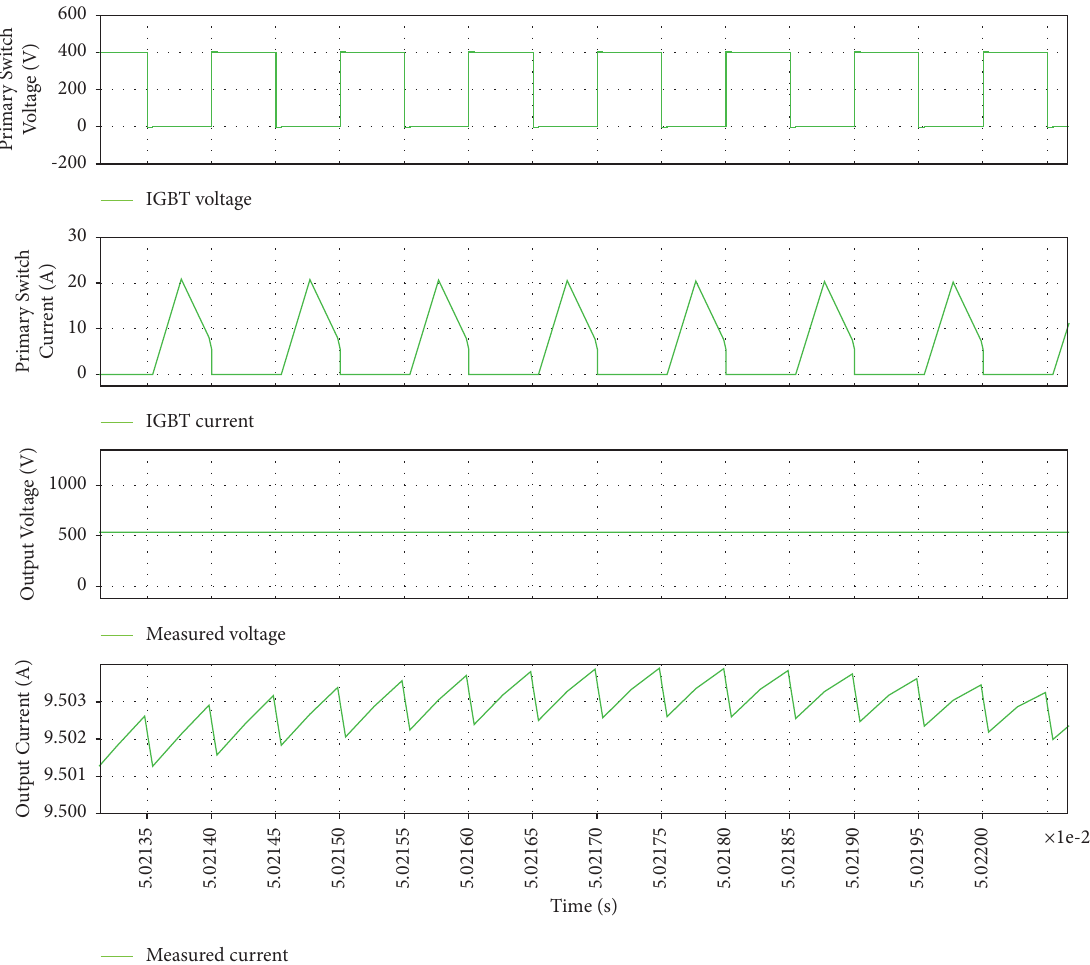
Figure 16: Simulated waveforms of the proposed converter with trench IGBT devices.